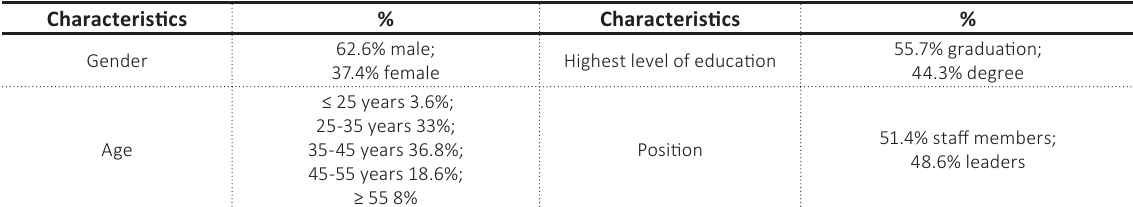
Table 2. Characteristics of respondents